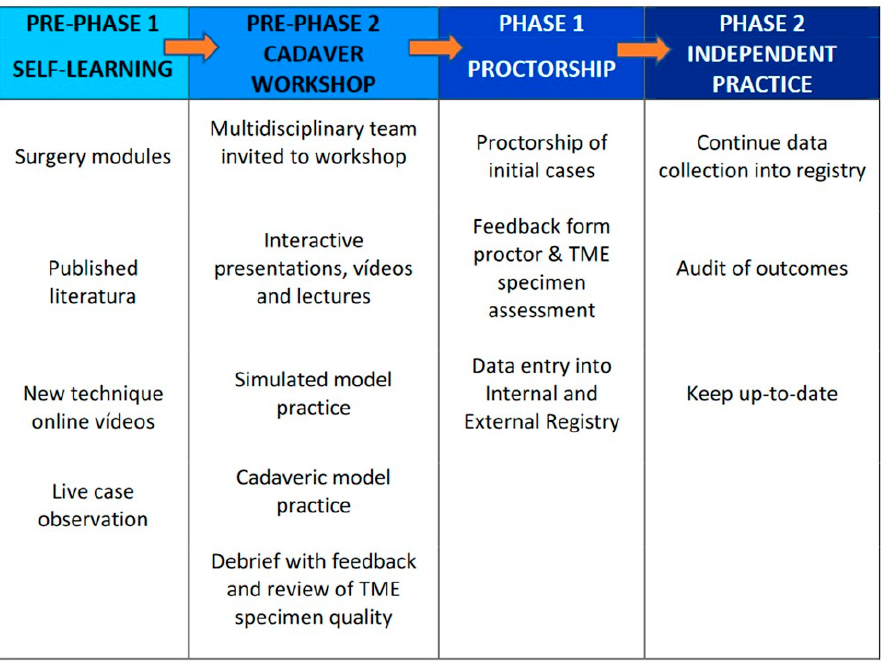
Figure 3. Training Curriculum for the Structured Adoption of New Techniques (Adapted from the Consensus on structured training curriculum for transanal total mesorectal excision (TaTME) Limitations